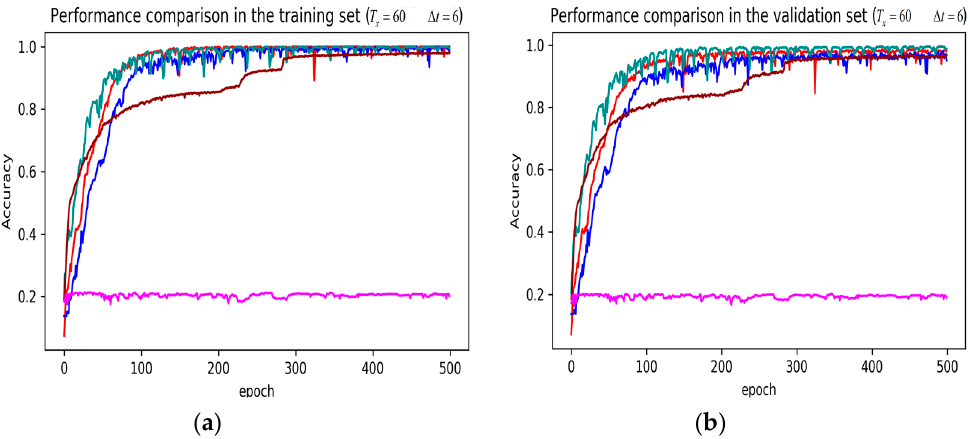
Figure 12. Performance comparison of different models in accuracy using original 51D features when setting T x to 60 samples and ∆ t to 6 samples. ( a ) Performance comparison in the training stage. ( b ) Performance comparison in the validation stage. Here, the attention-based DeepConvGRU and DeepConvLSTM also yielded good performance.